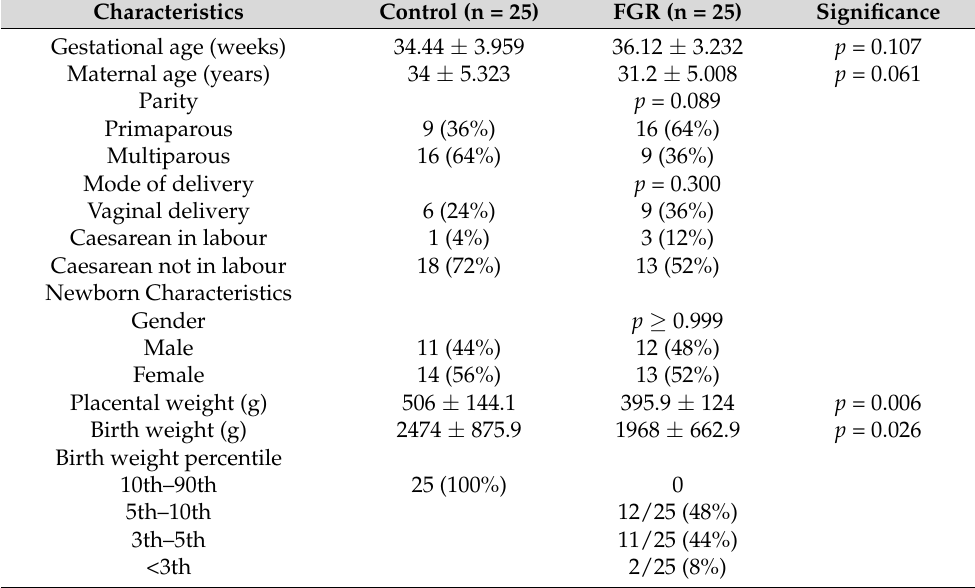
Table 1. Patient characteristics of third trimester FGR and uncomplicated